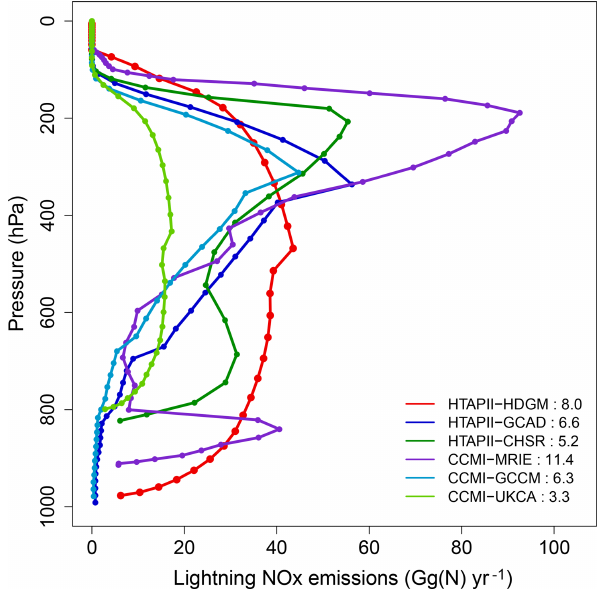
Figure 2. Annual vertical profiles of lightning NO x emissions over the domain considered in this study (inset: global emissions of light- ning NO x in Tg(N)year − 1 as simulated by each